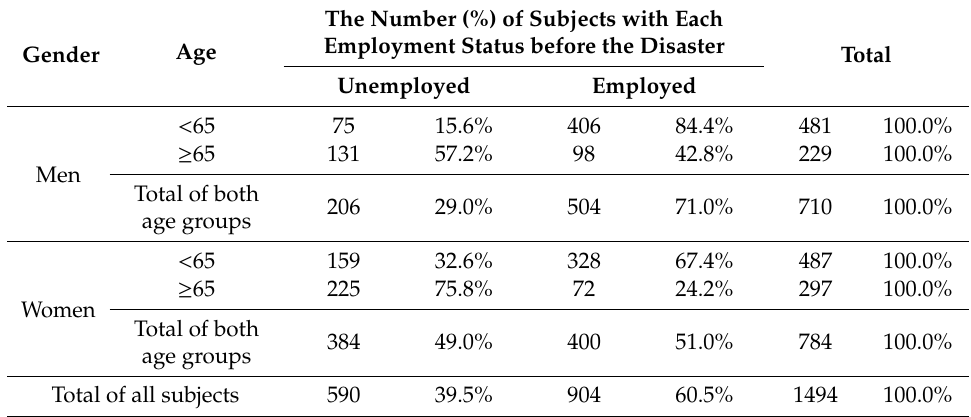
Table 1. Employment status of subjects before the Great East Japan Earthquake.